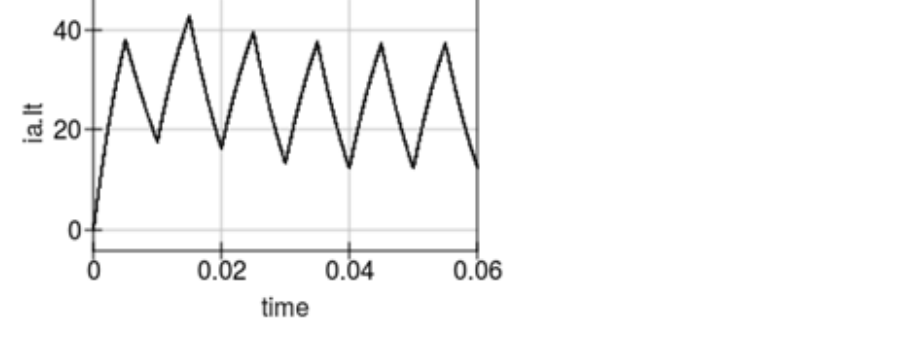
Figure 9. A simulation using Qucs of the armature current, i a ( t ) , under no-load conditions, when using a PWM supply voltage with a peak value of 100 V and a duty cycle of 50%.